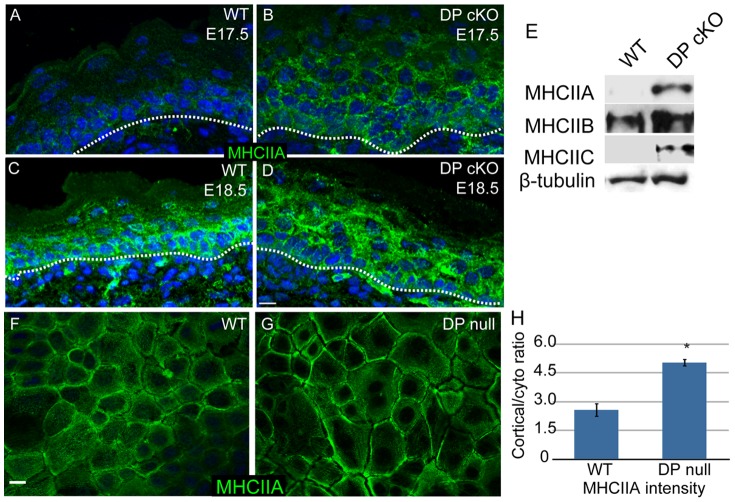
Myosin II levels and localization are upregulated in DP-null cells and epidermis.(A-D) WT (A, C) and DP cKO (B, D) epidermis at E17.5 (A, B) and E18.5 (C, D) were stained for myosin IIA (green). Basement membrane is marked with a dashed line. Scale bar, 10 µm. (E) Myosin II levels in E18.5 WT and DP cKO epidermis were evaluated by Western blot. β-tubulin is the loading control. (F, G) WT and DP-null keratinocytes were stained for myosin IIA (green). (H) Quantitation of cortical/cytoplasmic ratios of myosin IIA in WT and DP null cells. n>60 cells for two independent experiments, p = 0.027.